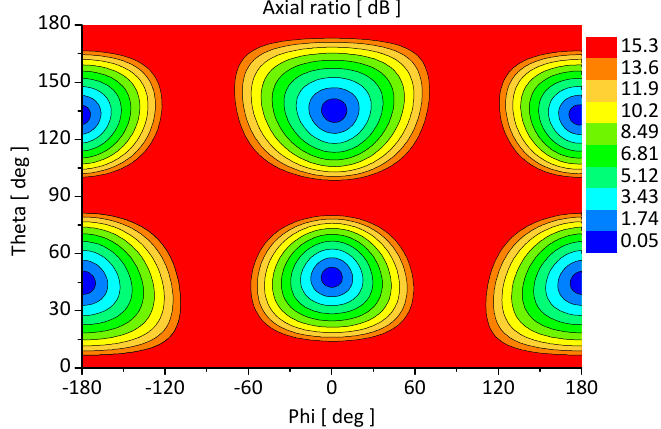
Figure 6. Simulation results of the axial ratio over the entire space.